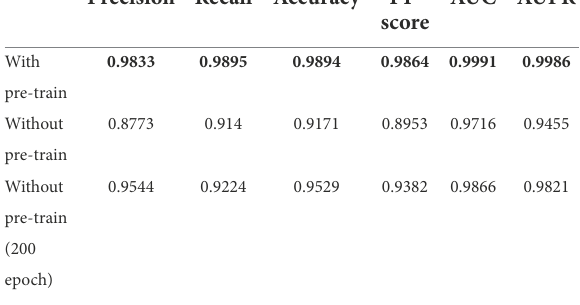
TABLE 6 The affect of transfer learning on the performance.